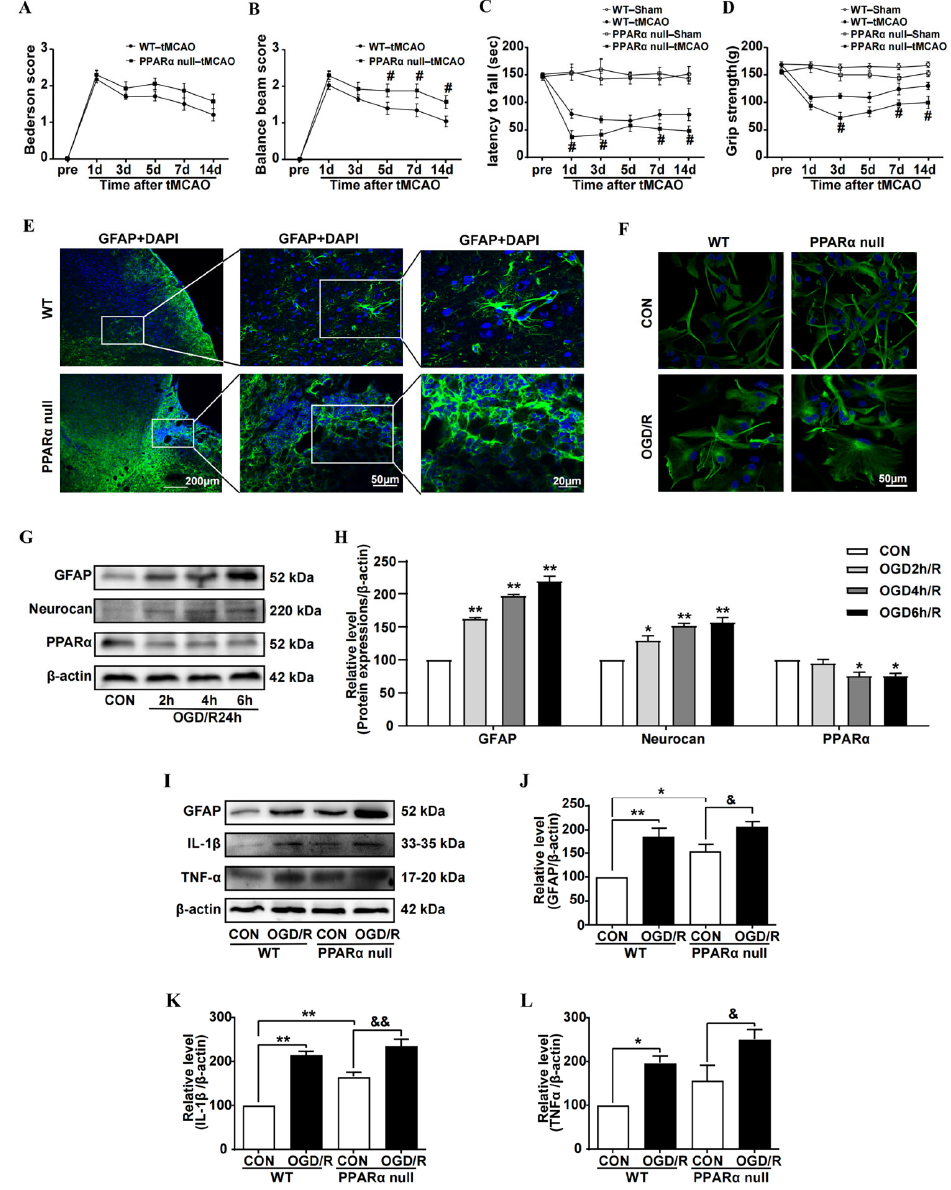
Figure 1. PPAR α dysfunction promotes astrocyte activation after transient brain ischemia. The Bederson scoring test ( A ), balance beam walking test ( B ), accelerated rotarod test ( C ), and grip strength test ( D ) were determined over 14 days after tMCAO. The values are expressed as the mean ± SEM; n = 3~10; two-way ANOVA for the differences within time points, followed by Bonferroni’s post-hoc test. The # p < 0.05 vs. WT tMCAO group. ( E ) The representative photographs of immuno- fl uorescence staining for the GFAP (green) expression in the ischemic boundary zone of brain sec- tions at day 14 after transient brain ischemia.Boxes: areas selected for higher magni fi cation. The representative photographs of immuno fl uorescence staining for GFAP (green) in the astrocytes from PPAR α -de fi cient mice and its WT control after OGD/R exposure ( F ). The immunoblo tt ing analysis and quanti fi cation of GFAP, neurocan, and PPAR α expressions in astrocytes after OGD for di ff erent times and then reoxygenation for 24 h ( G , H ). The immunoblo tt ing analysis and quanti fi cation of GFAP, IL-1 β , and TNF- α expressions in astrocytes from WT or in PPAR α -de fi cient mice after OGD/R exposure ( I – L ). OGD/R means OGD for 6 h and reoxygenation for 24 h. Data are expressed as the means ± SEM. * p < 0.05, ** p < 0.01 vs. WT normal control; & p < 0.05, && p < 0.01 vs. PPAR α de fi cit control.